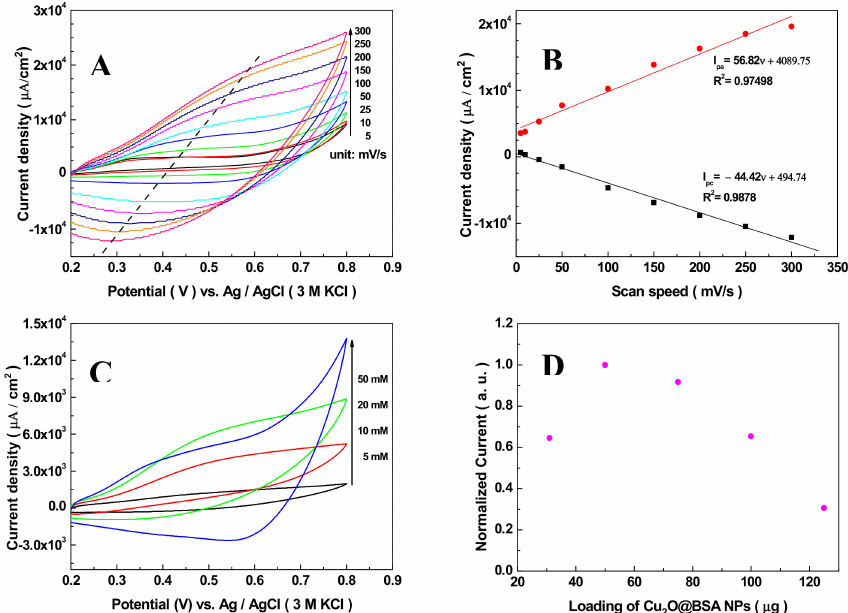
Figure 3. ( A ) CVs of the Nafion / Cu 2 O–BSA / GCE in 50 mM NaOH solution with 2 mM of glucose